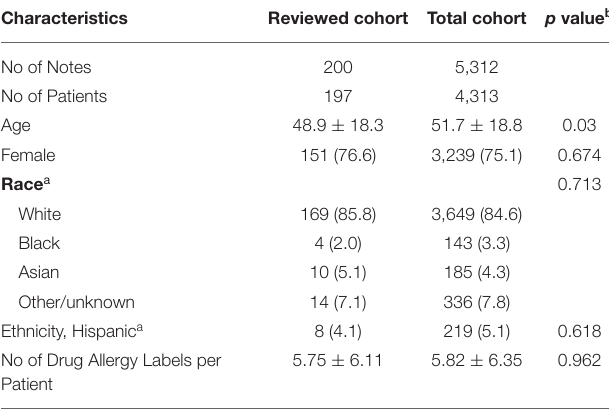
TABLE 1 | Demographic characteristics of patients cohort received drug challenge test. Characteristics